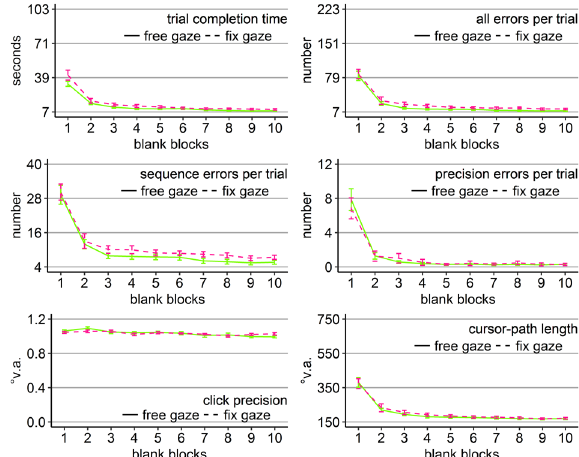
Figure 10. Performance measures during Experiment 5: Trial completion time in seconds, numbers of all errors, sequence errors, and precision errors per trial, click precision in °v.a., and cursor-path length in °v.a. (y-axes) over the course of the ten blank-screen blocks (x-axes) for the two groups (free gaze as pink solid line and fix gaze as green dashed line). Error bars represent standard errors of the